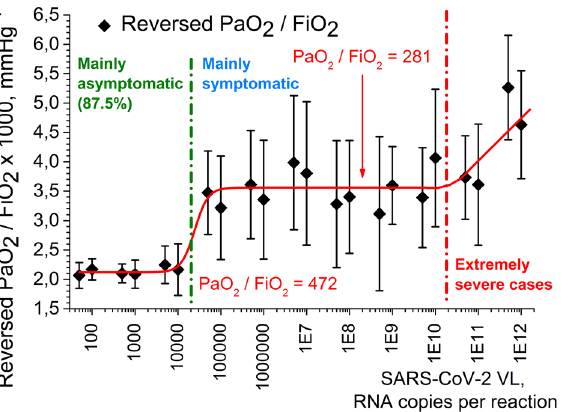
Figure 1. Correlation between reversed PaO 2 /FiO 2 ratio as an indicator of COVID-19 respiratory complications severity (the first item in ARDS score formula) and SARS-CoV-2 VL. In this and subsequent figures Confidence interval (CI) is 95%. Standard error of mean is showed as whiskers. Green dash-dotted line stands for the conditional border between asymptomatic carriers and symptomatic patients. Red dash-dotted line stands for the conditional border between extremely severe clinical cases and the rest of the patients. Percentage numbers in parentheses (green) correspond to the proportion of asymptomatic carriers whose manifestations fit into the conditional range to the left of the green line. Created in OriginPro ver. 9.2.196, https:// www. origi nlab. com.